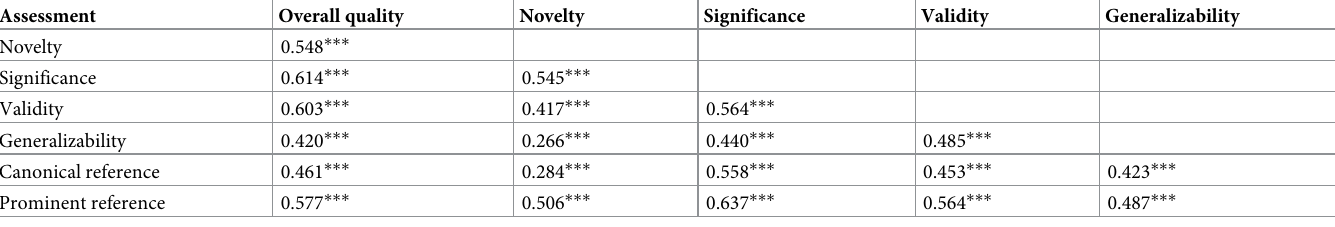
Table 6. Correlations (Sperman’s rho coefficients) between quality related assessments and (overall) quality assessment.